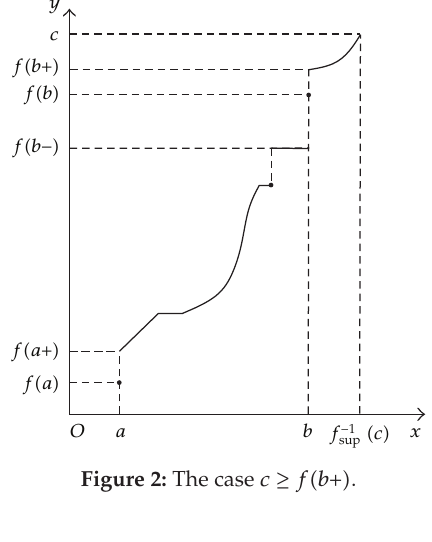
Figure 2: The case c ≥ f (cid:5) b (cid:7)(cid:4) .